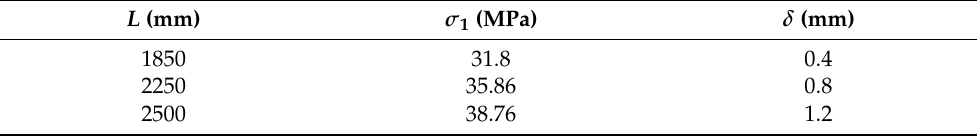
Table 2. Results of the flexibility